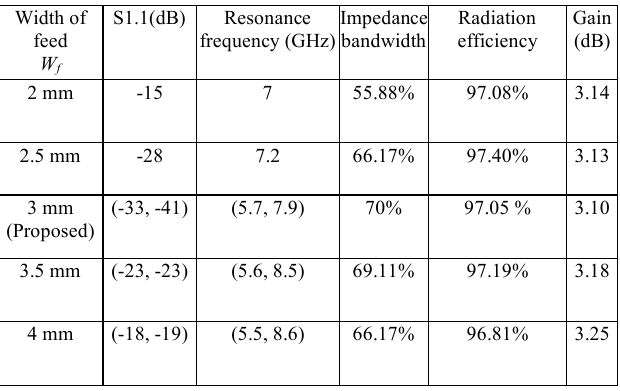
Table 4: Comparison of proposed model based on W f . Width of feed